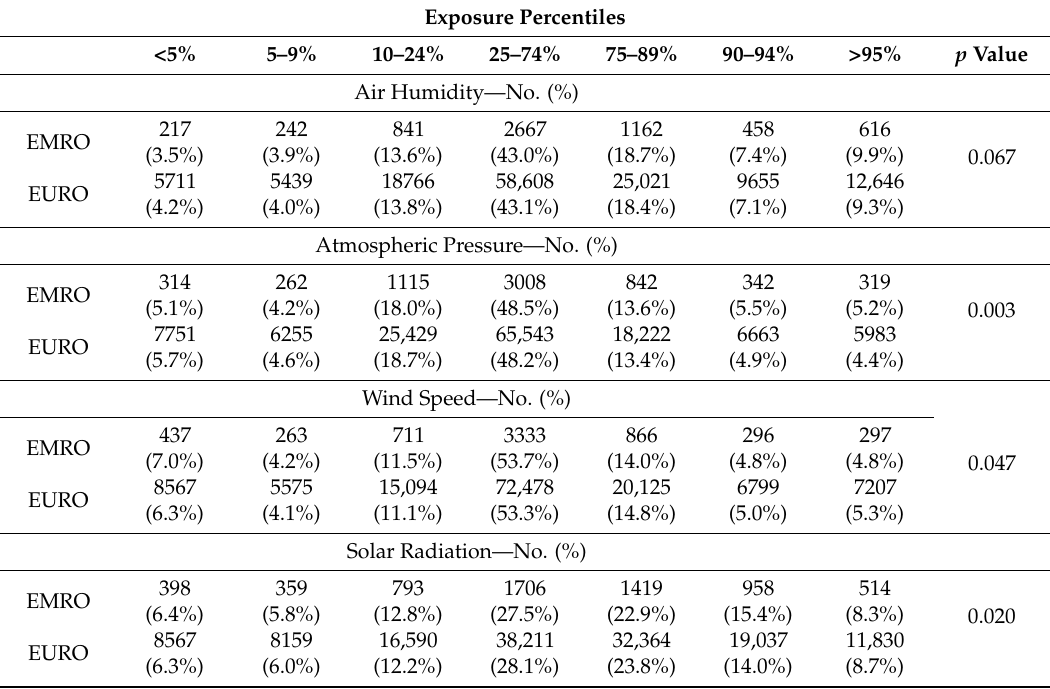
Table 6. Occurrence of Occupational Injuries in EURO and EMRO workers by exposure groups to Air humidity, Atmospheric pressure, Wind Speed, Solar radiation indices broken down by percentiles. Distribution of Occupational Injuries by exposure percentiles and worker groups was assessed through chi squared test (p value; significance level for p <